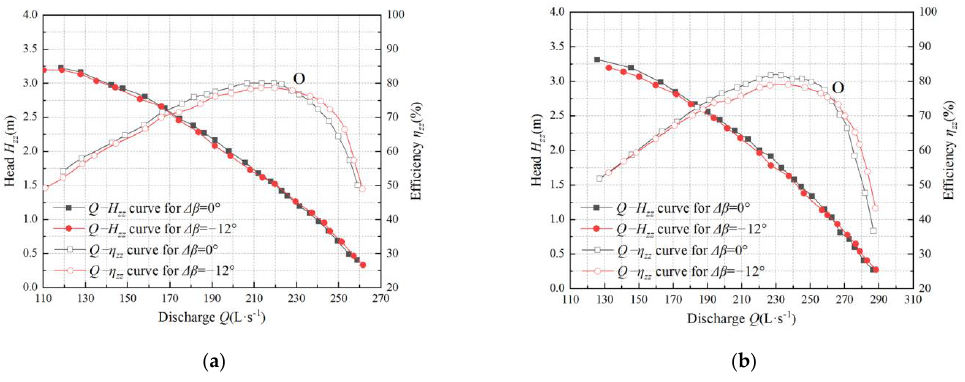
Figure 13. Comparison of energy performance under ∆ β = 0 ◦ and ∆ β = − 12 ◦ in pump device, ( a ) α = − 2 ◦ , ( b ) α = 0 ◦ . Table 3. The energy performance parameter under ∆ β of 0 ◦ and − 12 ◦ in the shaft tubular flow pump device. Optimal Working Condition of Pump Device Intersection O of the Q ~ η zz with ∆ β of − 12 ◦ and 0 ◦ α ∆ β